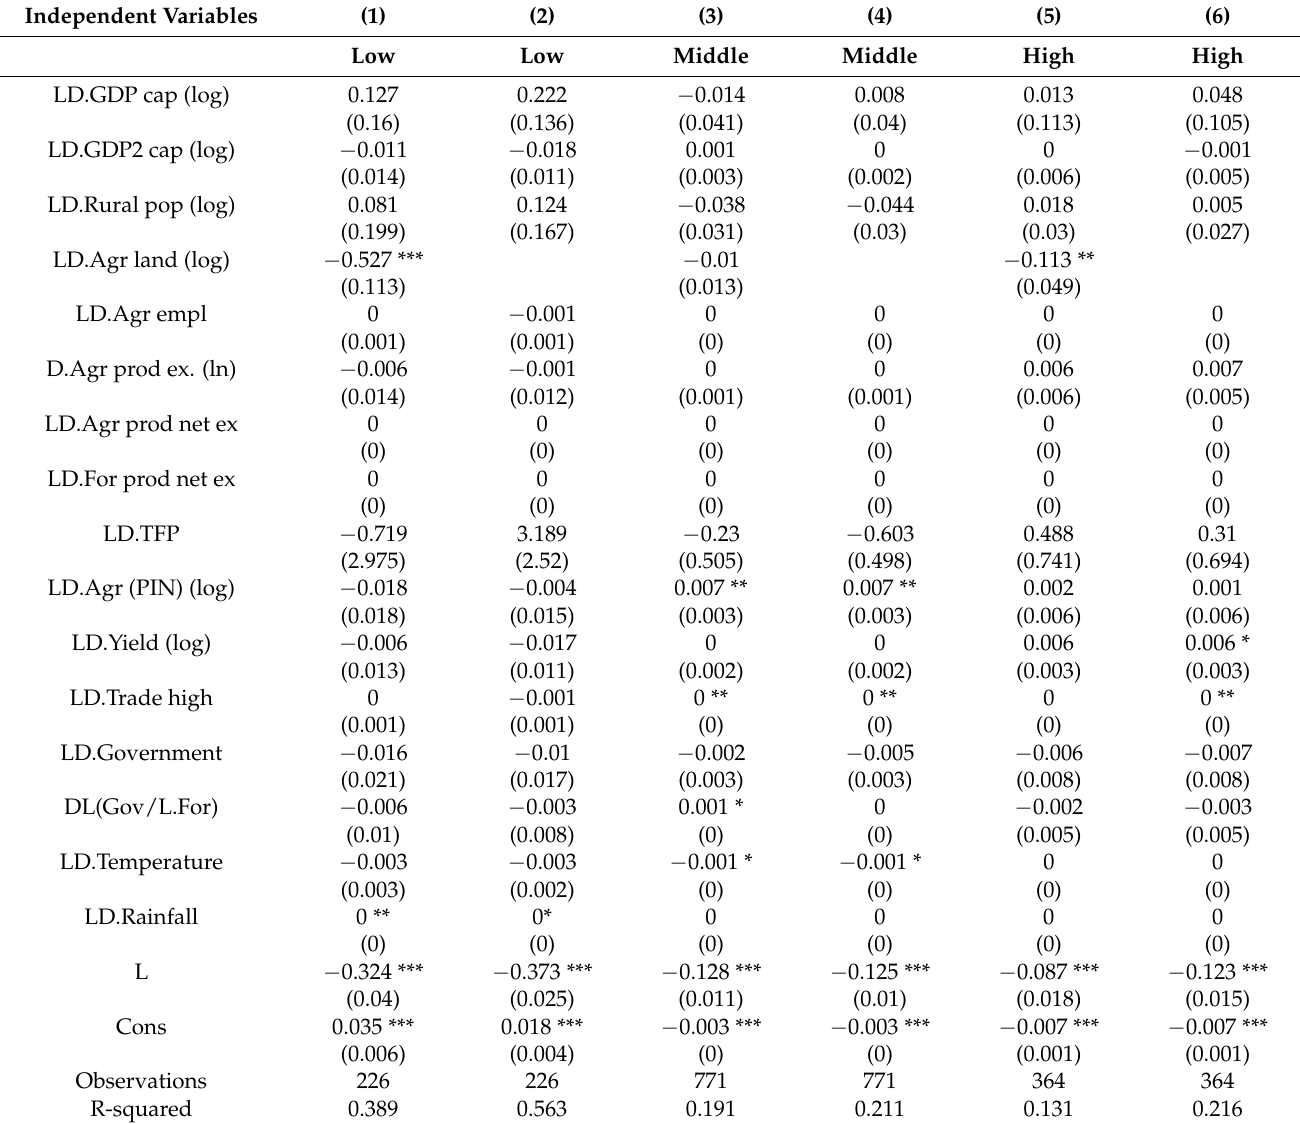
Table A3. Short run, income clusters, net agricultural exports as additional control variable.